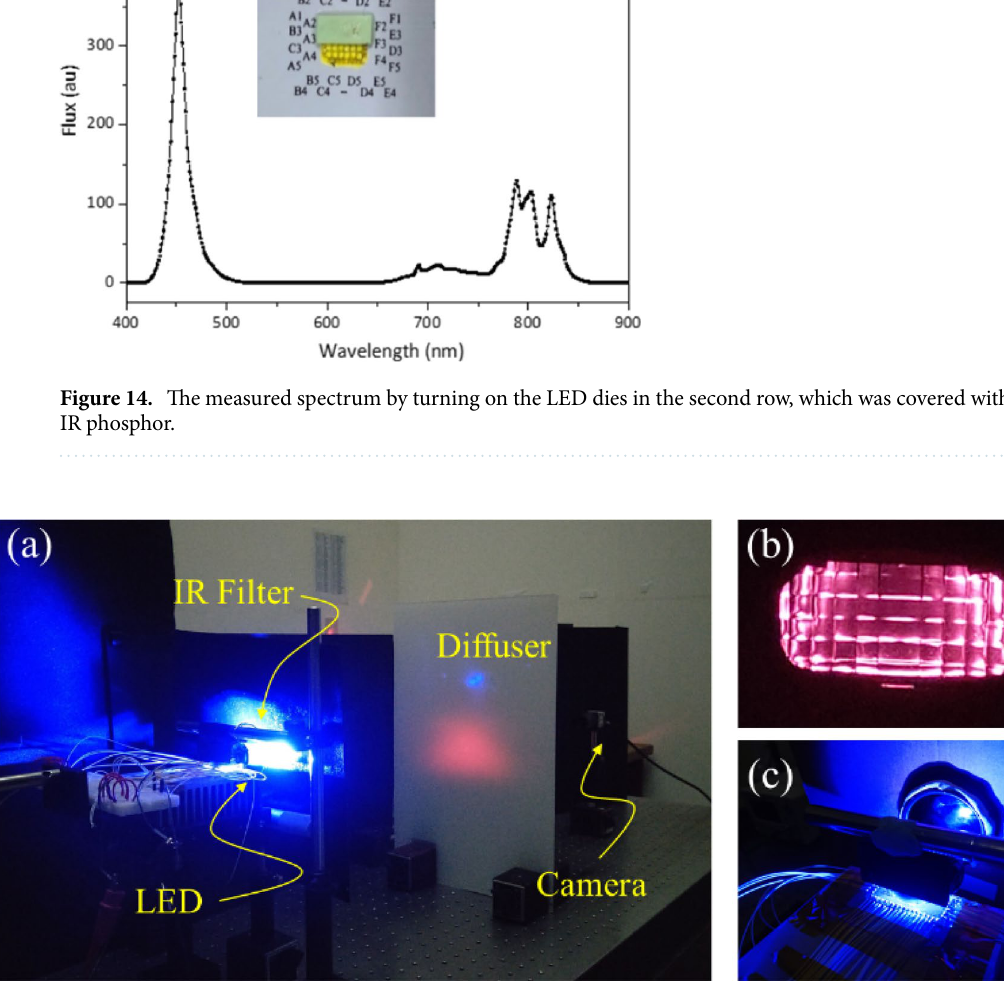
Figure 15. ( a ) The experiment setup, ( b ) viewing the reflector through the IR filter, and ( c ) viewing the IR filter from the LED side. The light pattern is up side down in the experiment owing to the setup